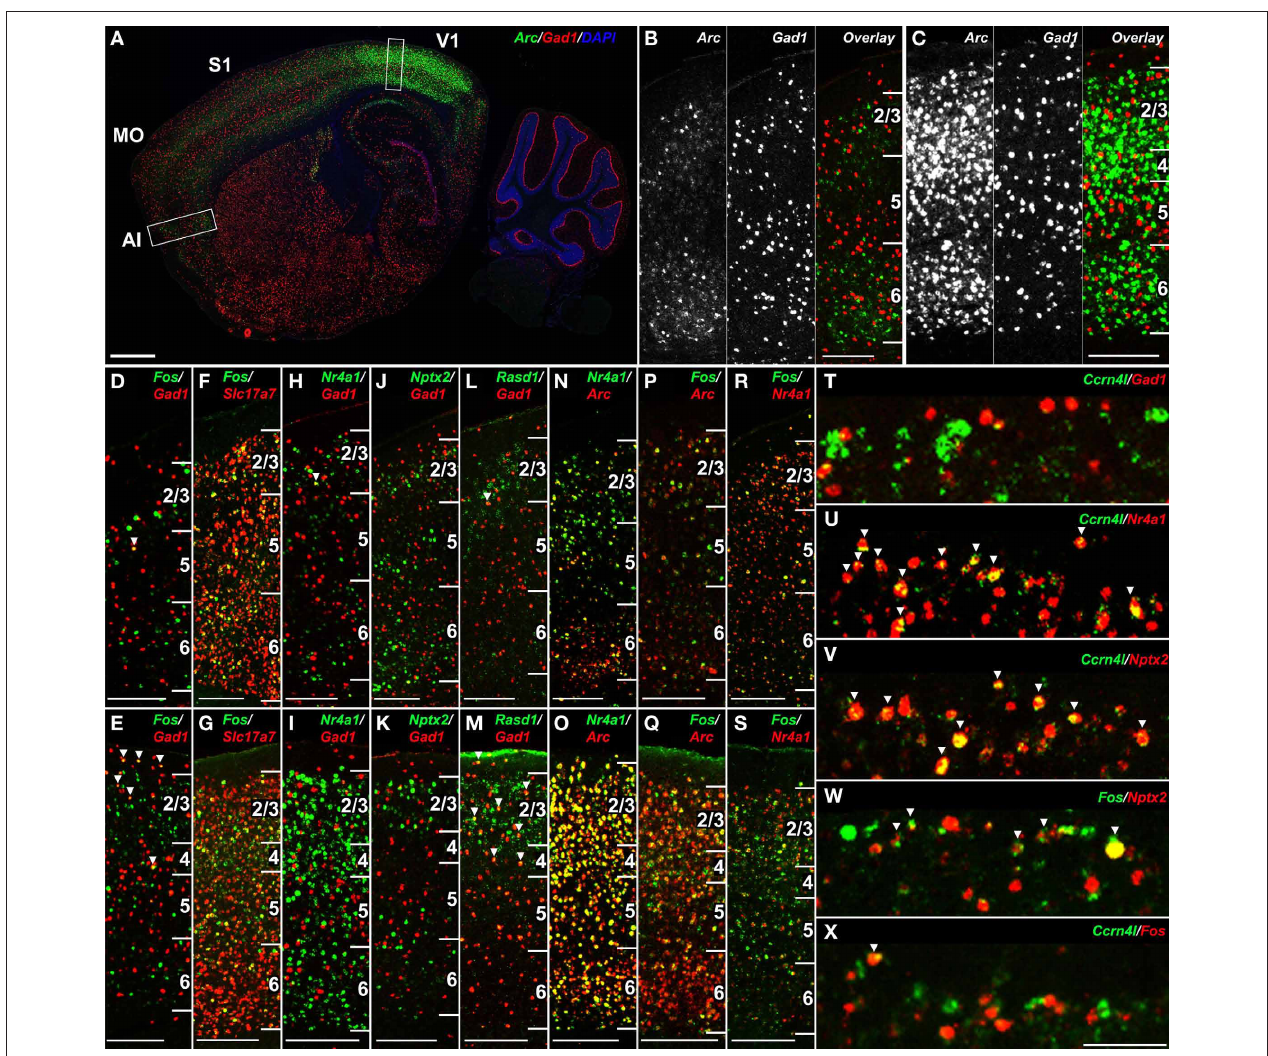
(e,g,i,K,M,O,Q,S) . Fos is largely restricted to excitatory neurons (D–g) , neither Nr4a1 nor Nptx2 colocalize with Gad1 (H–K) , and Rasd1 partially overlaps with Gad1 (L,M) . Arc , Nr4a1 and Fos label partially overlapping neuronal populations (N–S) . (T–X) Gene-specific cellular specificity in layer 2 of somatosensory cortex following SD. Ccrn4l is expressed in a subset of Nr4a1 and Nptx2 -positive excitatory neurons (T–V) , Fos partially overlaps with Nptx2 (W) , yet Ccrn4l